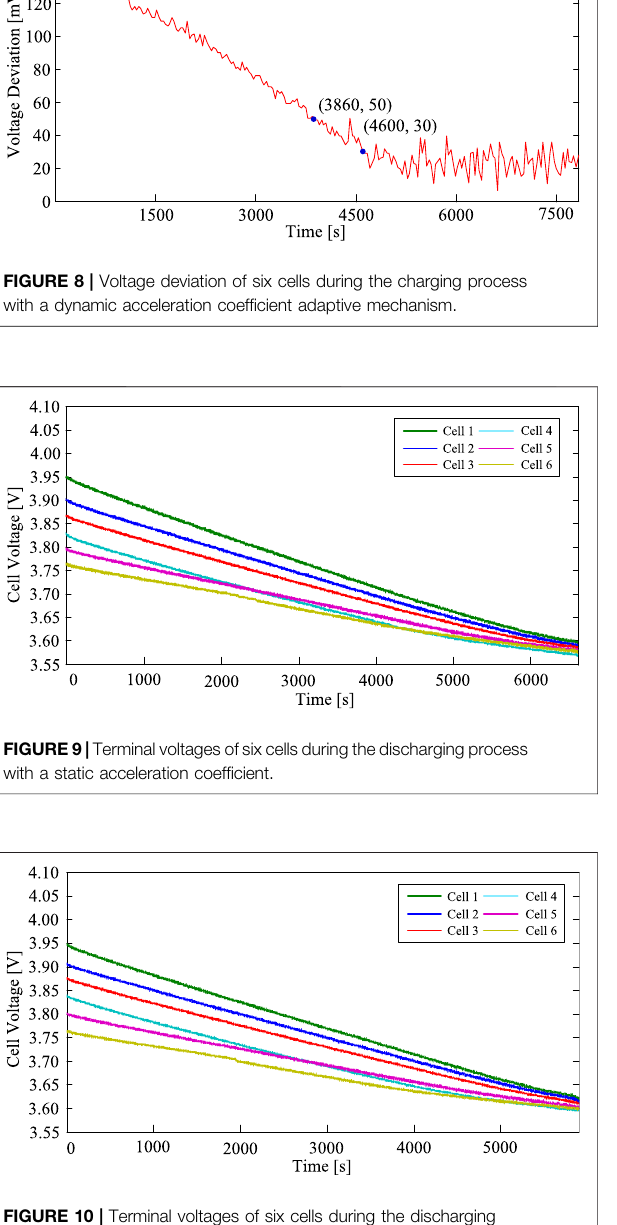
FIGURE 10 | Terminal voltages of six cells during the discharging process with a dynamic acceleration coef fi cient adaptive mechanism.